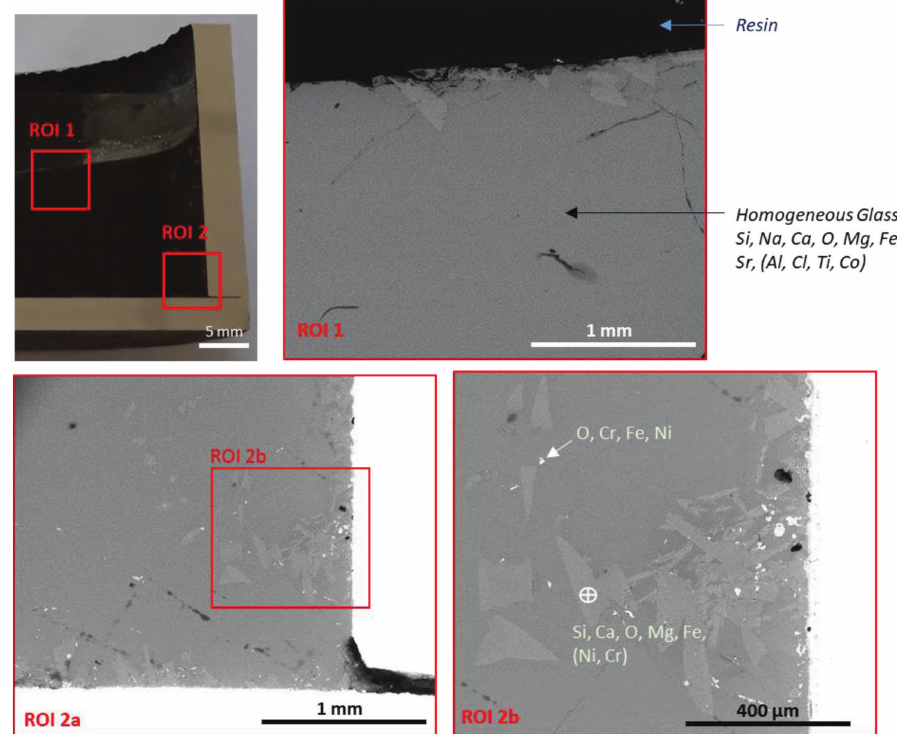
Fig. 3. SEM imaging of the wasteform, WL ox = 40 wt.%.